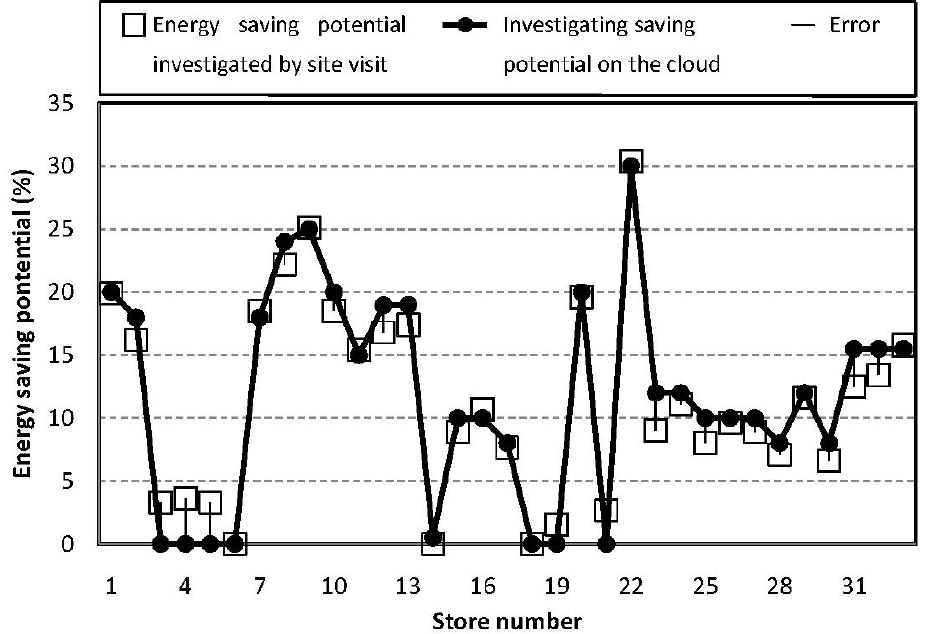
Figure 12. Cloud sensor system uses 8D data array to investigate energy saving potential. Investigation gives errors within 4.17%. It’s noted that the trend of investigation fully matches the real saving potential obtained from site visit and eight stores have low saving potential less than 5% are successfully screened